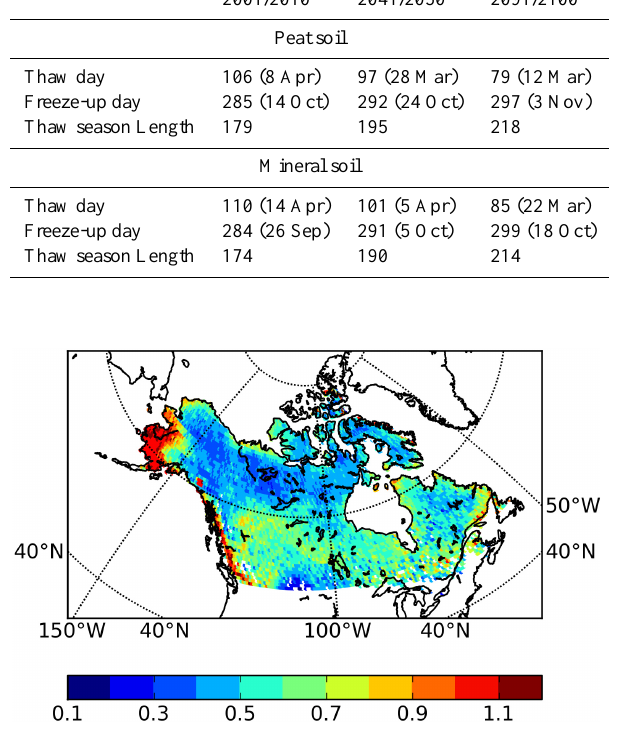
Fig. 3. Significant trends [daysa − 1 a − 1 ] in freeze-free period in the model domain, derived from the soil surface temperature at 0.05m for 2001–2100.